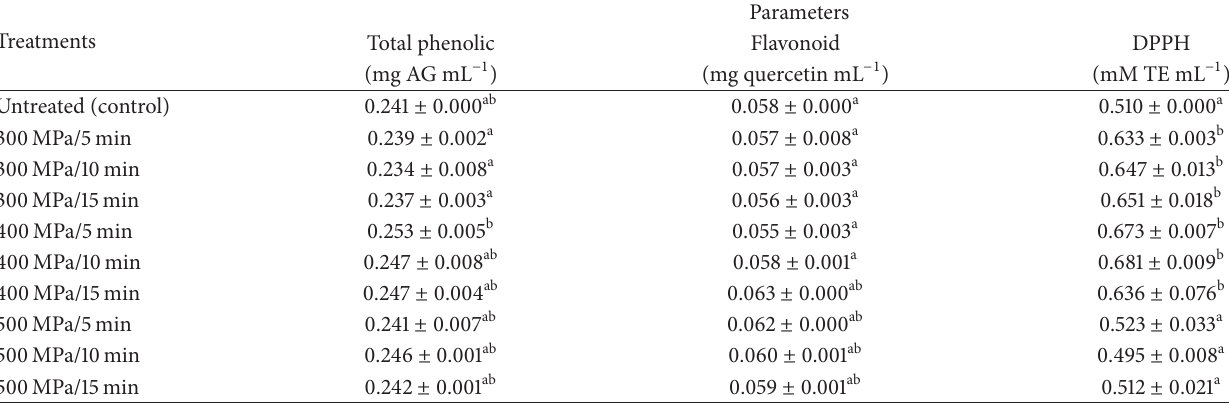
Table 5: Effects of HHP on total phenols, flavonoid content, and antioxidant activity expressed as DPPH (mM TE mL −1 ) of white wine.